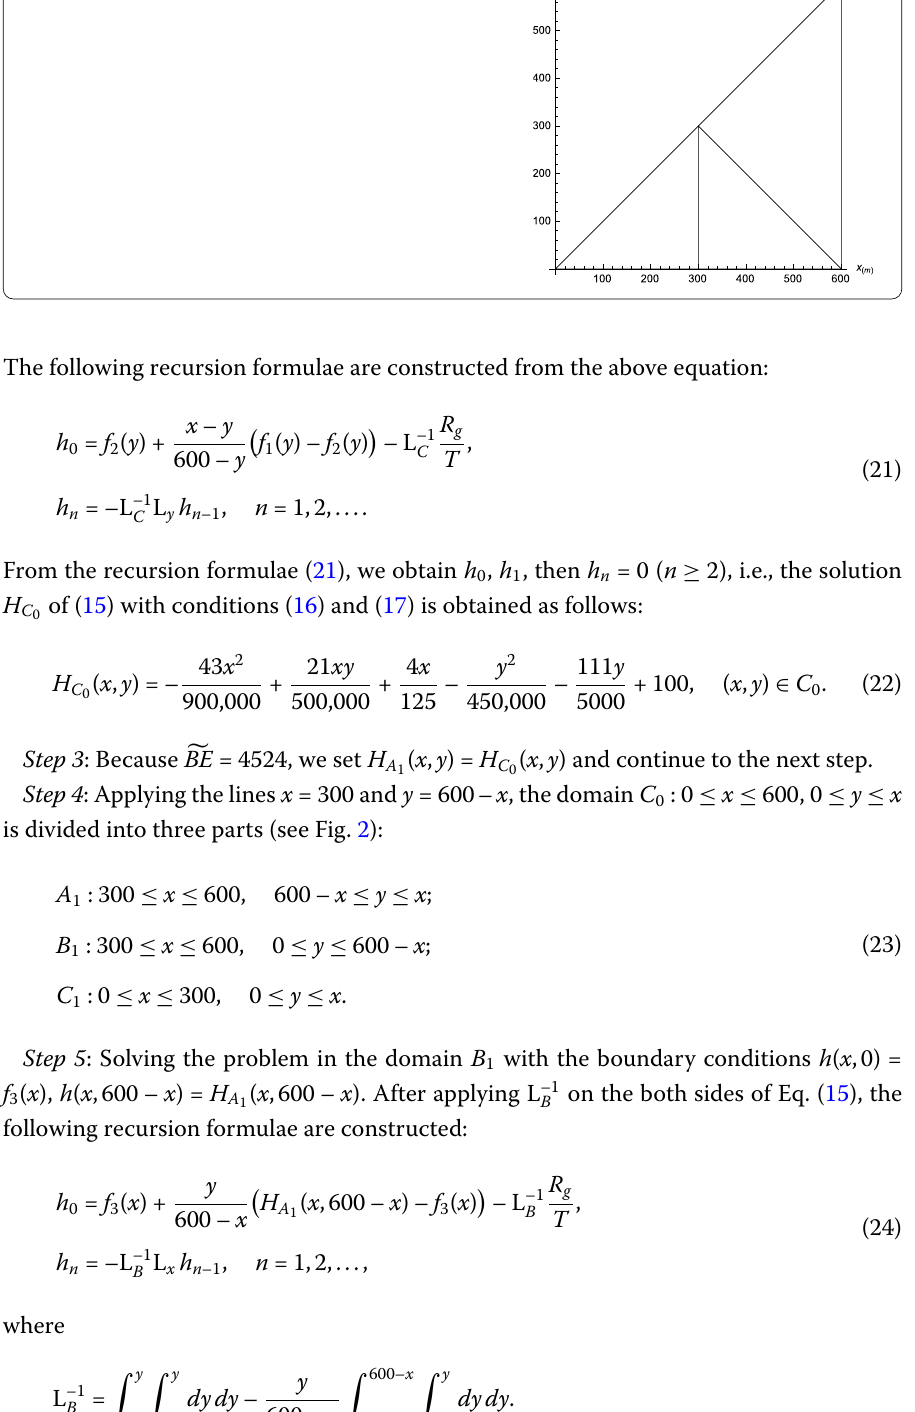
Figure 2 Regional